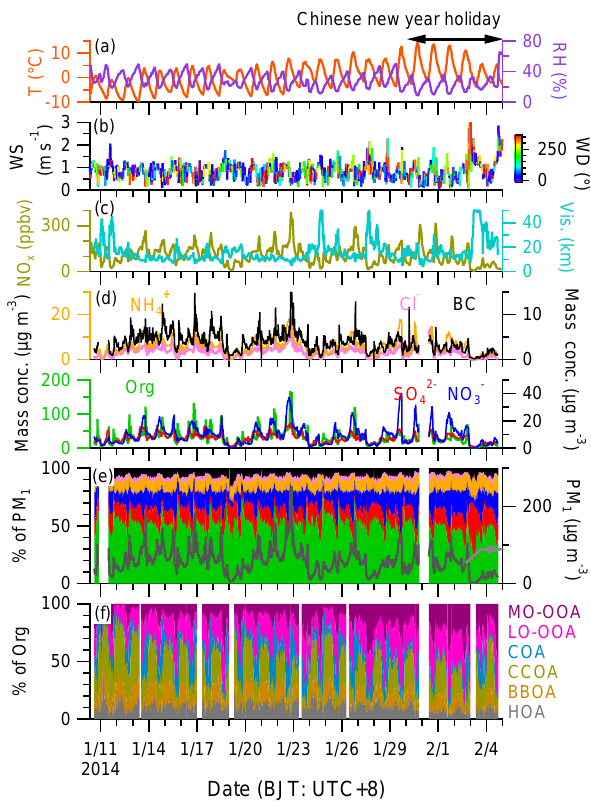
Figure 1. Summary of meteorological and aerosol species data. (a) air temperature ( T ) and relative humidity (RH), (b) wind speed (WS) colored by wind direction (WD), (c) NO x and visibility, (d) mass concentration of PM 1 species, (e) the mass contribution of PM1 species (BC is from aethalometer measurement), and (f) the mass contribution of organic components to organic aerosol. Note that BC is from aethalometer